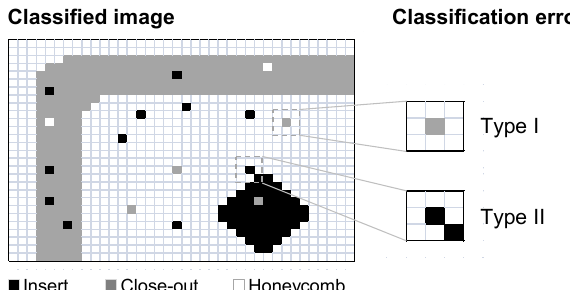
Figure 8. Definition of detectable classification errors by type.